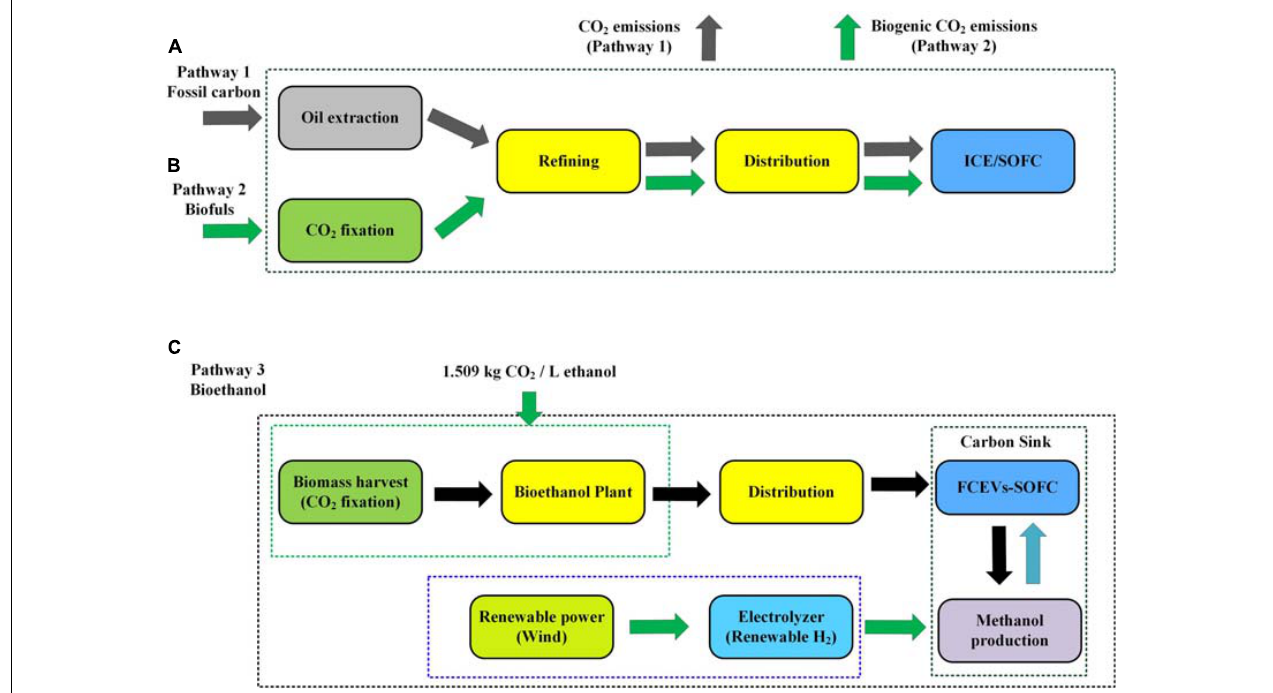
FIGURE 1 | The various pathways of the transportation and distributed power system. (A) Pathway 1—fossil carbon. (B) Pathway 2—biofuels. (C) Pathway 3—bioethanol.